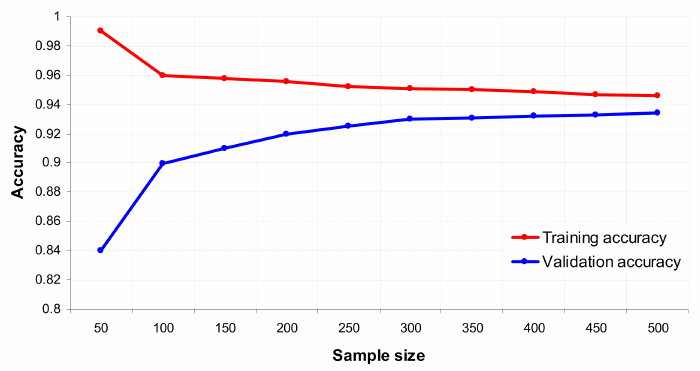
Figure 7. Learning